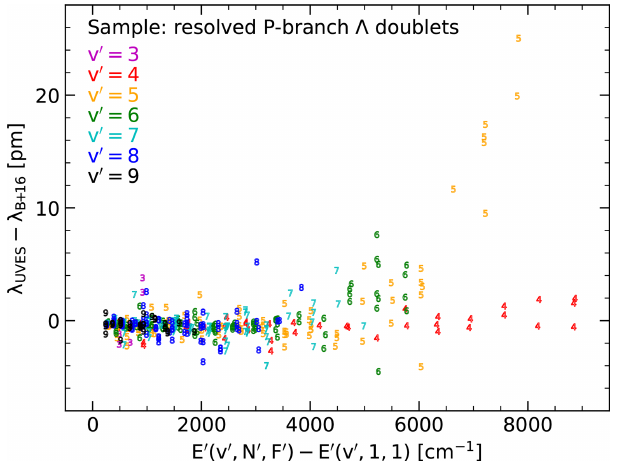
Figure 4. Wavelength difference between the UVES-based mea- surement of isolated P -branch lines (resolved (cid:51) doublets) and the corresponding position provided by Brooke et al. (2016) (similar to HITRAN) in picometres as a function of the energy of the up- per state of the transition E (cid:48) with respect to the lowest energy of the corresponding vibrational level v (cid:48) in inverse centimetres. The coloured markers indicate v (cid:48)